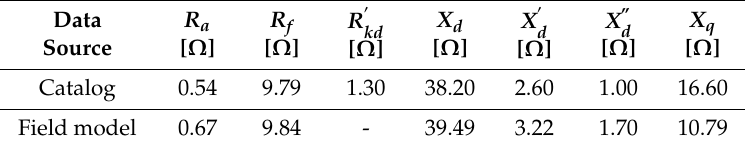
Table 5. The 16-kVA generator electrical parameters for catalog data and field